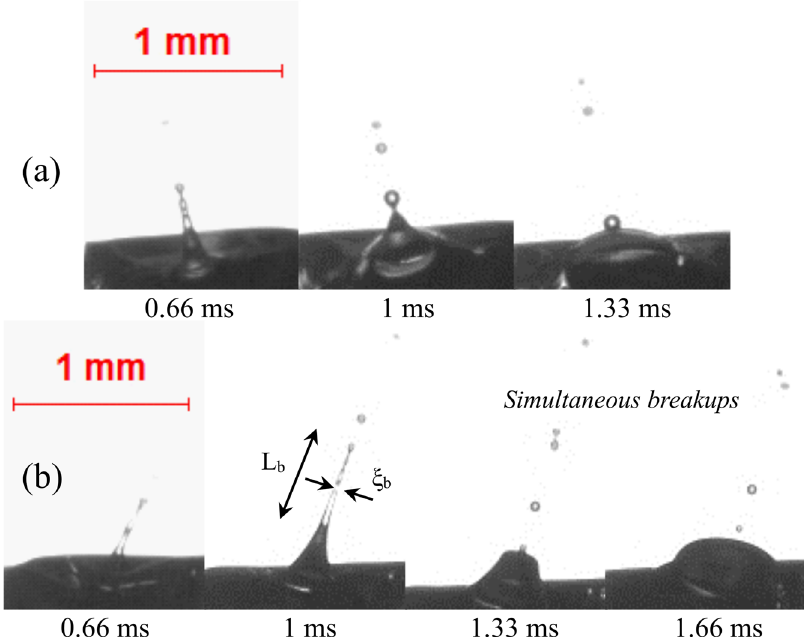
Figure 2. High aspect ratio, needle type ligament growth and breakup (Mode 1) for ( a ) α = 0.02, AR = 10.8 and ( b ) α = 0.05, AR = 15, representing simultaneous necking and pinch-off of secondary droplets in a typical E10 and B30 droplets. Both the ligament and the ejected secondary droplets carry high momentum (max. velocity ~2 m/s) upon the breakup of the bubble.